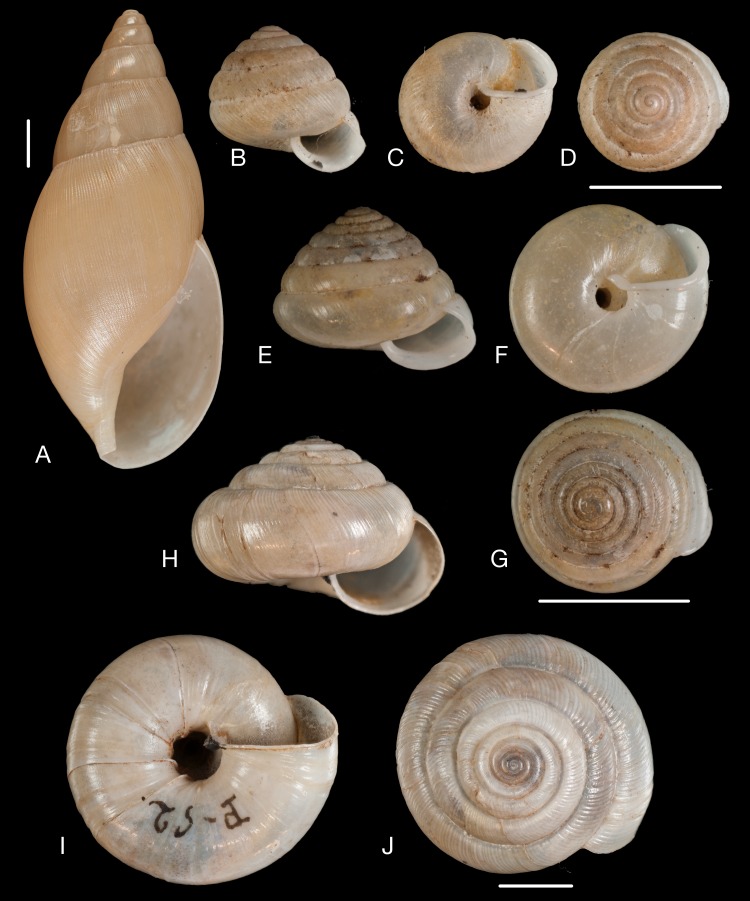
Material collected by the CCP.(A) Spriraxidae. Euglandina (Cosmomenus) cumingi (Beck, 1837), MNCN 15.05/76219, (A) ventral view. (B–J) Streptaxidae. Hypselartemon deshayesianus (Crosse, 1863), MNCN 15.05/19843, (B) ventral view, (C) umbilical view, (D) apical view; Hypselartemon paivanus (Pfeiffer, 1867), MNCN 15.05/20124, (E) ventral view, (F) umbilical view, (G) apical view; Rectartemon candidus (Spix in Wagner, 1827), MNCN 15.05/20123, (H) ventral view, (I) umbilical view, (J) apical view. Scale line 5 mm.